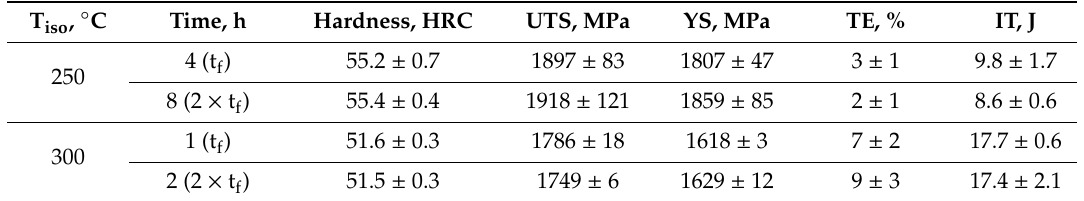
Table 2. Hardness, ultimate tensile strength (UTS), yield strength (YS), total elongation (TE), and impact toughness (IT) of nanobainitic cast steels.